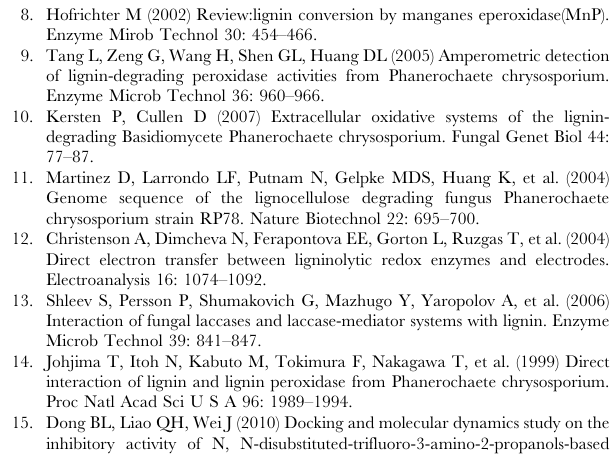
Table S1 List of residues forming contacts with the ligand lignin in PDB entry 1LLP. Table S2 List of residues forming contacts with the ligand lignin in PDB entry 3M5Q. Table S3 List of residues forming contacts with the ligand lignin in PDB entry